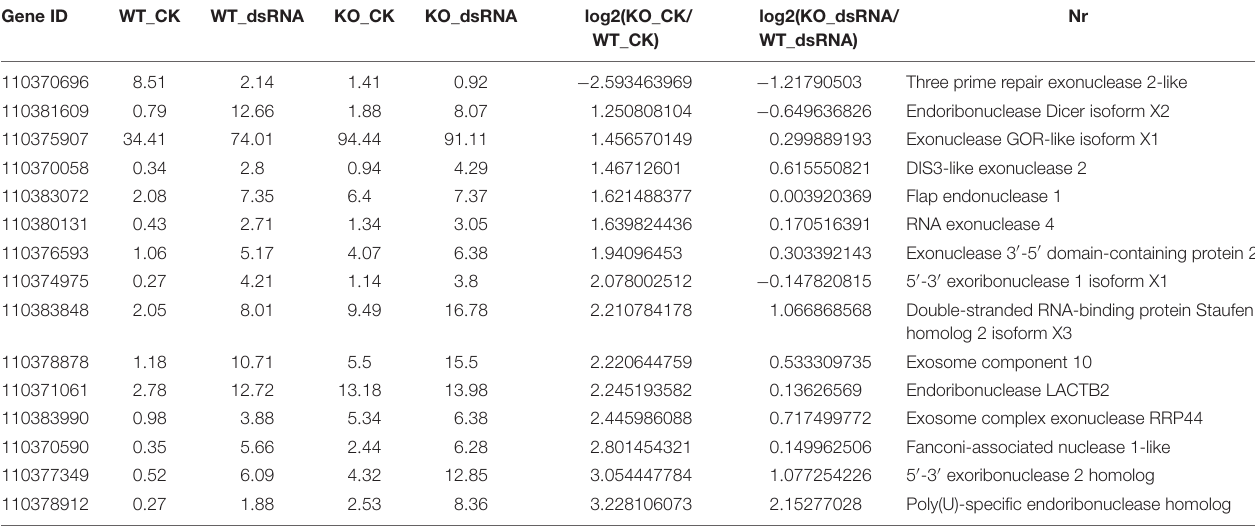
TABLE 3 | Expression levels of nuclease genes in WT and KO cotton bollworm before and after dsRNA